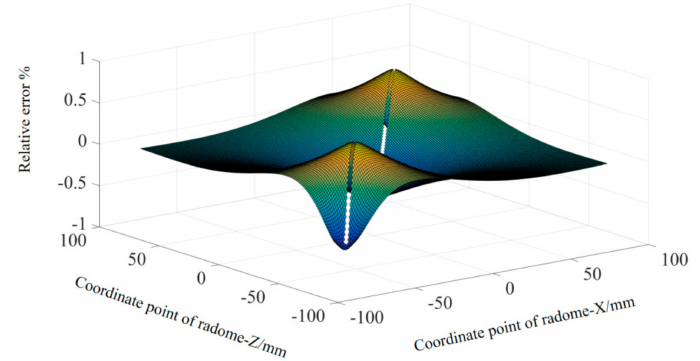
Figure 10. Accuracy error cloud map.